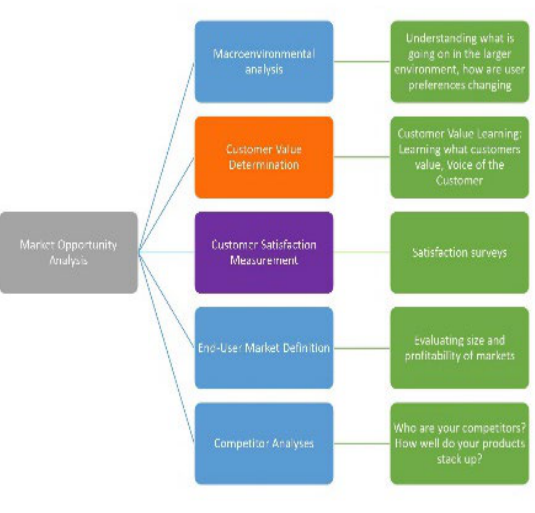
Figure adapted from: Woodruff RB, Gardial SF. Know Your Customer: New Approaches to Understanding Customer Value and Satisfaction. Malden, MA: Wiley-Blackwell,